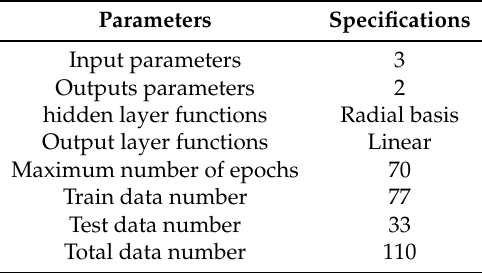
Table 4. Specifications of the proposed RBF